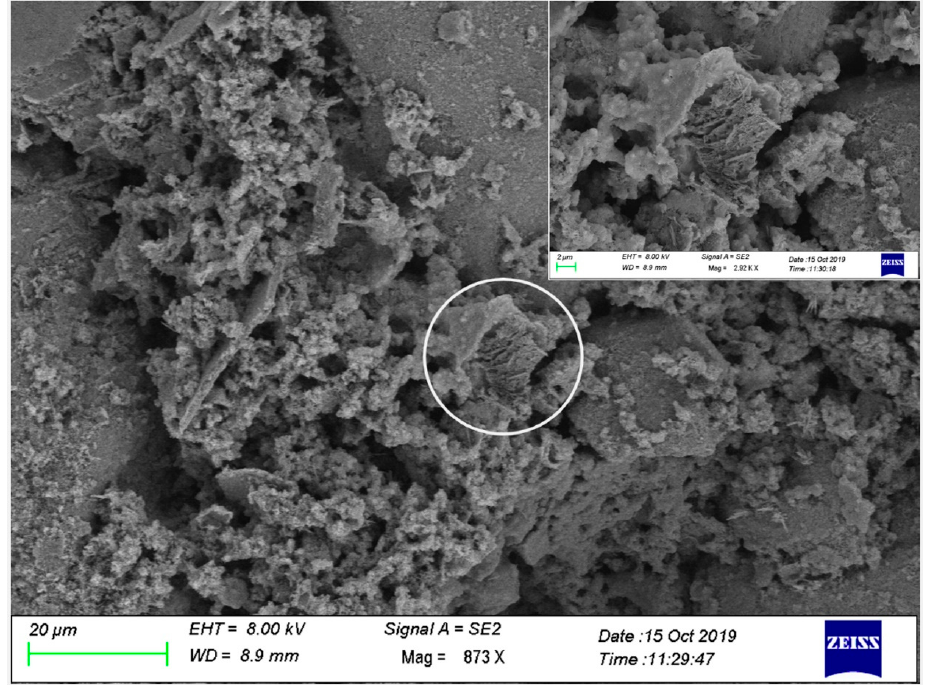
Figure 7. SEM view of N1-10 RHA cement at 28 d.